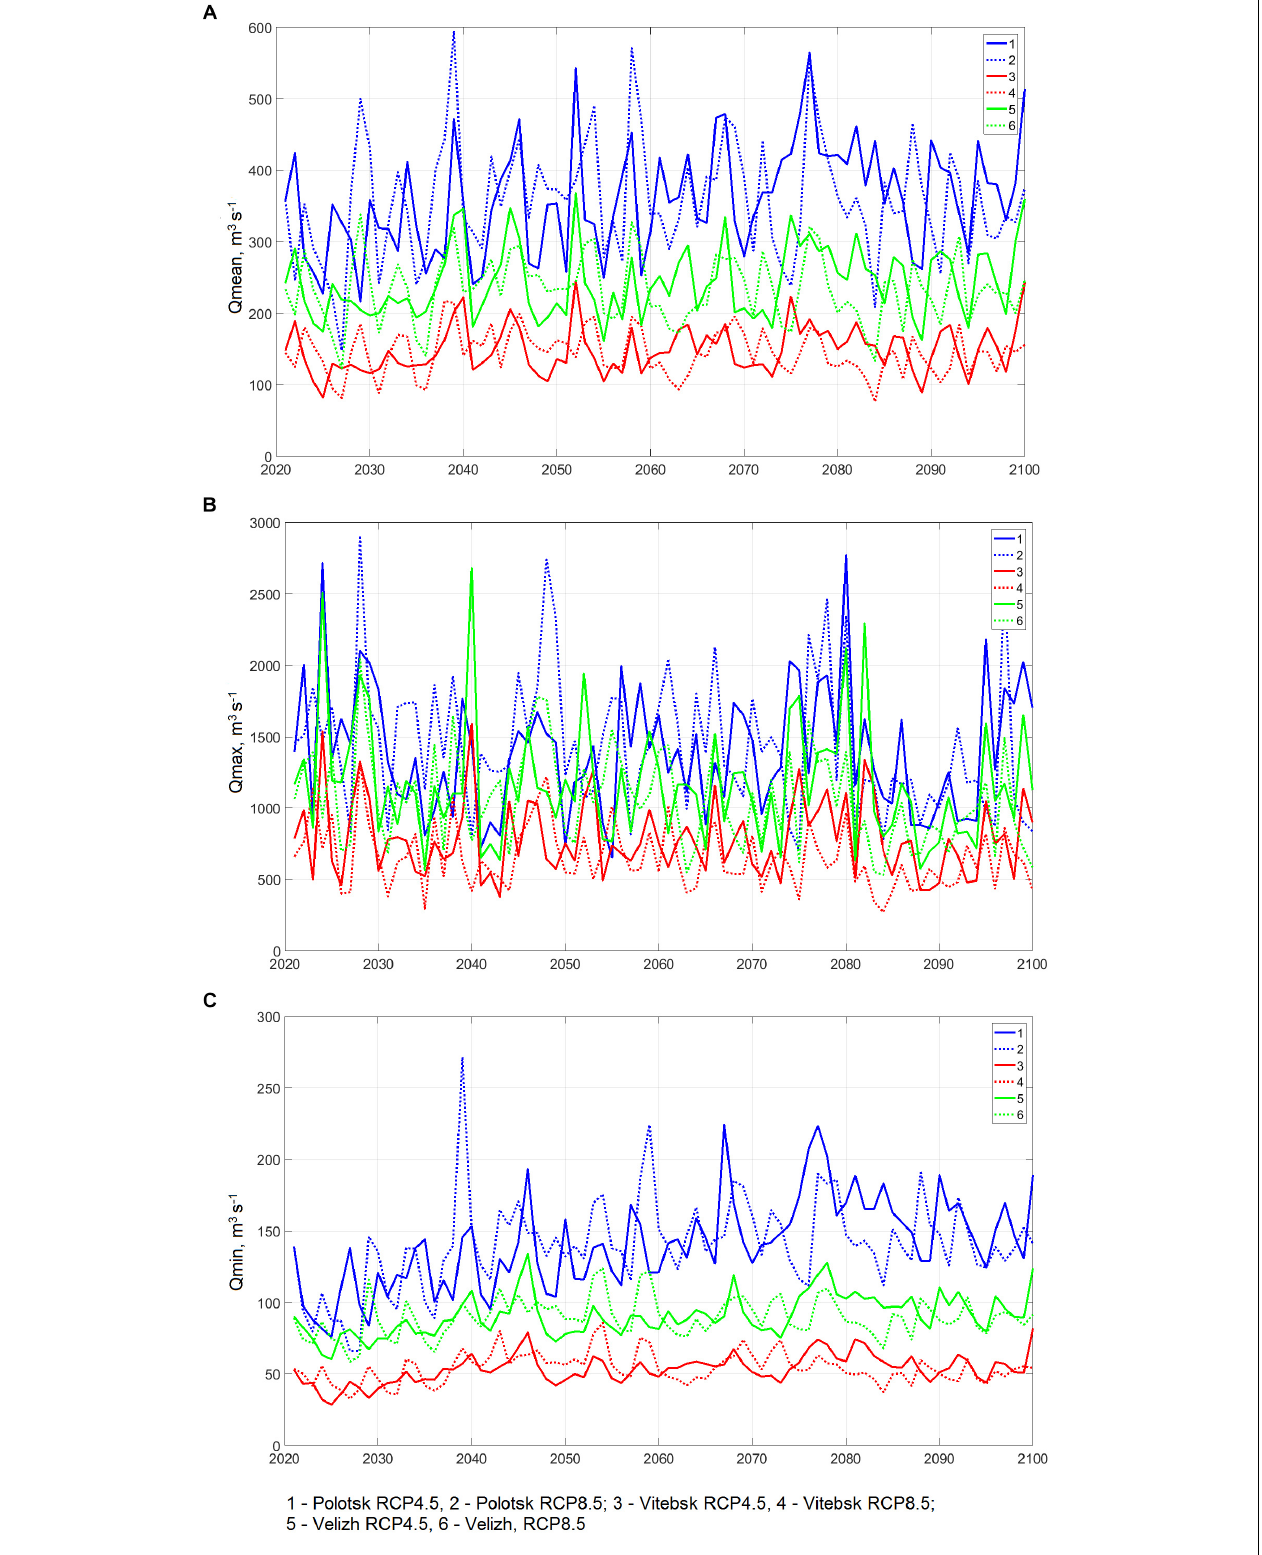
FIGURE 12 | Projected annual (A) , maximum (B) , and minimum (C) streamflow on the Western Dvina River during the 2021–2100 period.